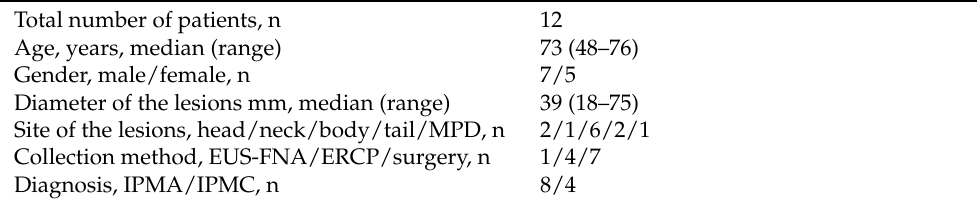
Table 1. Clinical and pathological features of IPMN lesions.